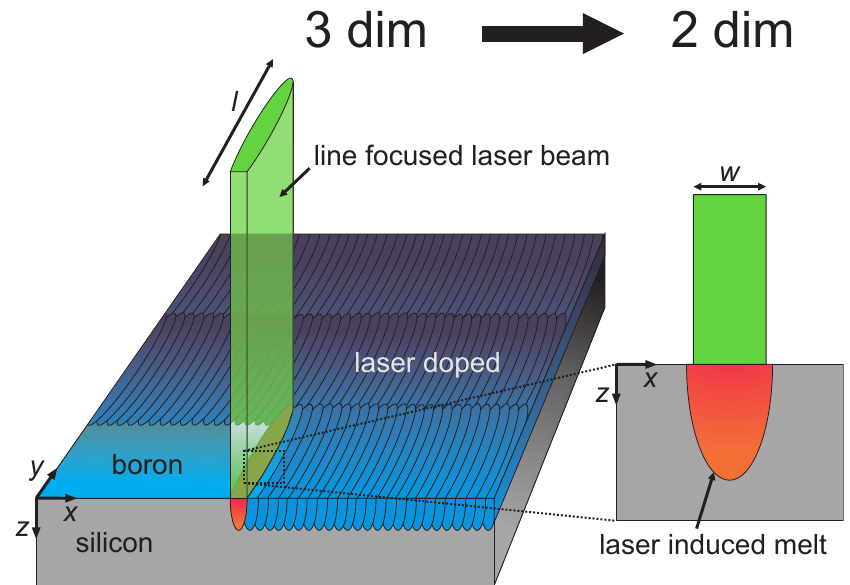
Figure 1. Sketch of the laser doping process. A line-shaped pulsed laser emitting at wavelength λ = 532 nm scans the wafer surface with a Gaussian intensity profile with full width at half maximum w = 7 µ m along the short axis ( x -direction) and a l = 800 µ m top-hat profile in the long axis ( y -direction). Due to the line-shaped laser beam with l >> w , the gradient of the laser intensity in the y -direction is much smaller than in the x -direction. Hence, this justifies the reduction into two dimensions to numerically solve the heat transport and diffusion